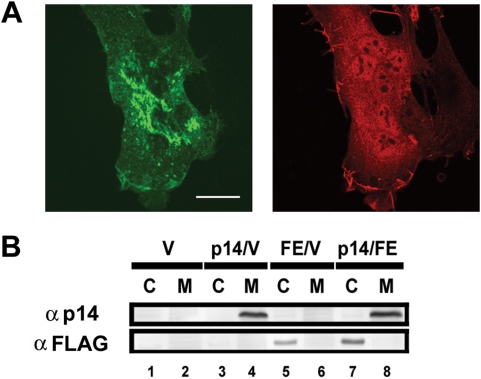
The p14 endodomain is a soluble nucleocytoplasmic peptide.(A) Cells were co-transfected with HA-tagged p14 and FLAG-tagged p14 endodomain, fixed and permeabilized at 8 h post-transfection, and stained using rabbit anti-HA and mouse anti-FLAG antibodies and appropriate fluorescently tagged secondary antibodies. The HA-tagged p14 (left panel) exhibited punctate, reticular staining in the cytoplasm while the FLAG-tagged p14 endodomain (right panel) was broadly distributed throughout the cytosol and nucleus. Scale bar = 20 µm. (B) Cells were co-transfected with the indicated expression plasmids (p14, full-length p14; V, empty vector; FE, FLAG-tagged p14 endodomain), and cell lysates were fractionated into the cytosolic “C” and membrane “M” fractions before being processed for Western blotting using anti-p14 or anti-FLAG antibodies (indicated on the left).